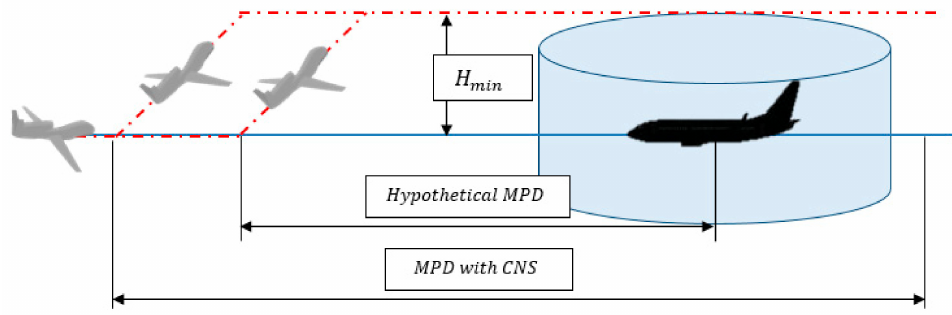
Figure 4. Schematic diagram of conflict-resolution between a RPAS and a conventional aircraft.